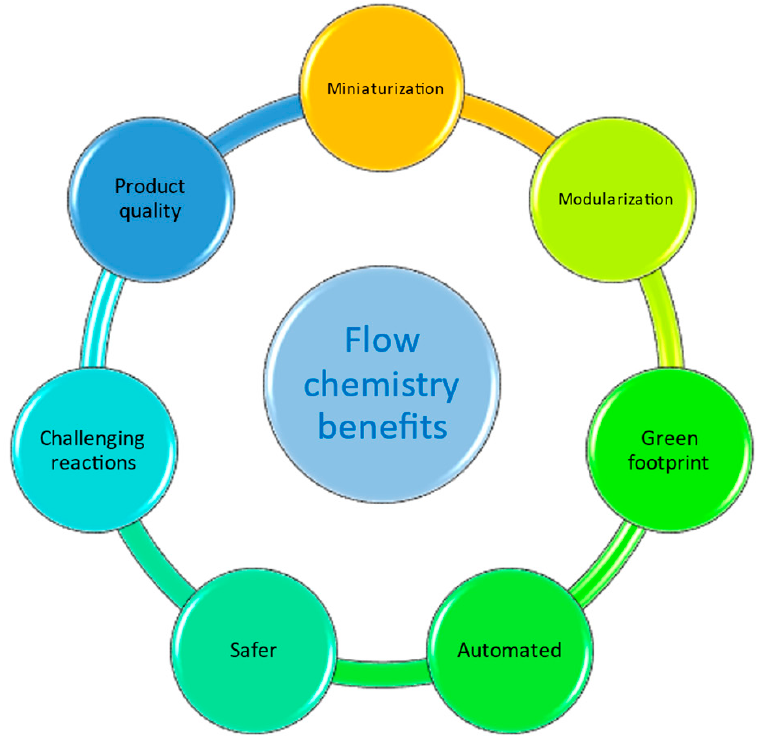
Figure 2. The advantages of flow chemistry for the pharmaceutical industry.